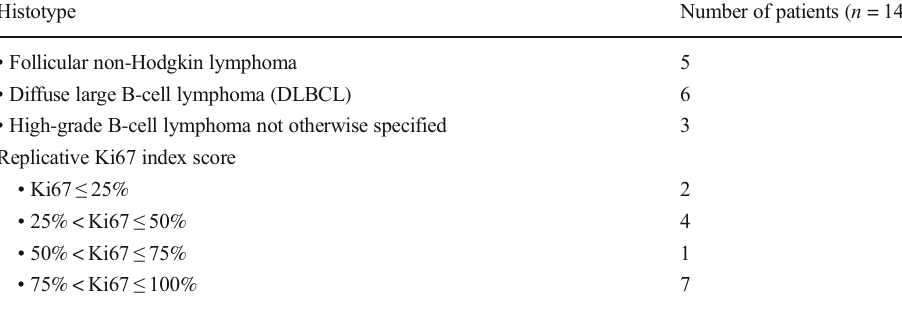
Table 2 Histopathological